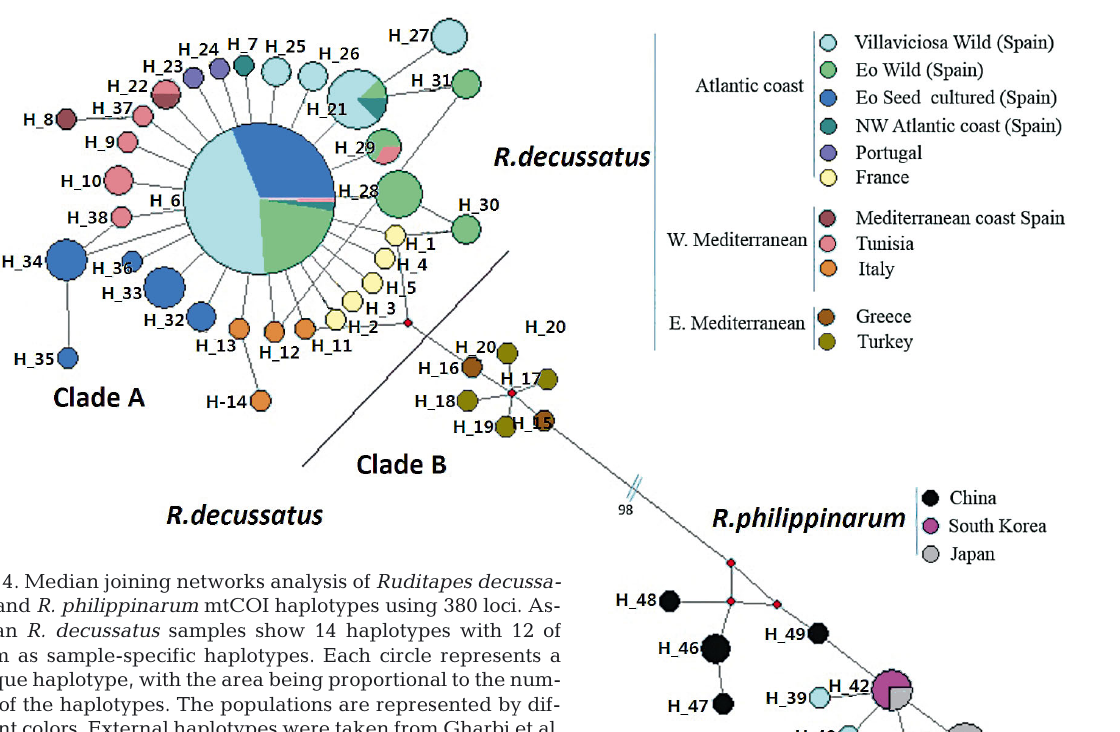
Fig. 4. Median joining networks analysis of Ruditapes decussa- tus and R. philippinarum mtCOI haplotypes using 380 loci. As- turian R. decussatus samples show 14 haplotypes with 12 of them as sample-specific haplotypes. Each circle represents a unique haplotype, with the area being proportional to the num- ber of the haplotypes. The populations are represented by dif- ferent colors. External haplotypes were taken from Gharbi et al. (2010), Mao et al. (2011), Cordero et al. (2014), and from the BOLD systems (see ‘Materials and methods’ for details). The mutational steps between both species are indicated